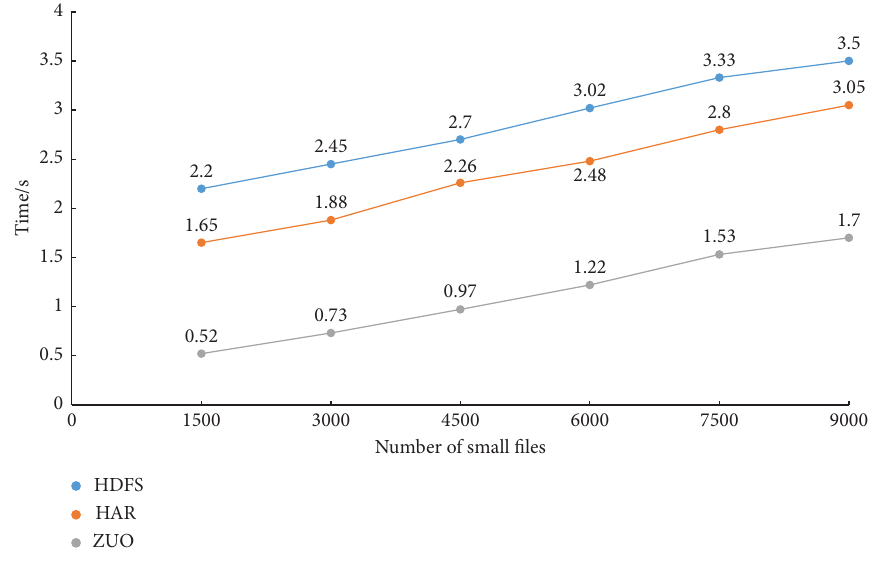
Figure 7: Comparison of small fle reading time. Table 1: Clustering results of the SEEDS dataset (number of wrong clusters per class).